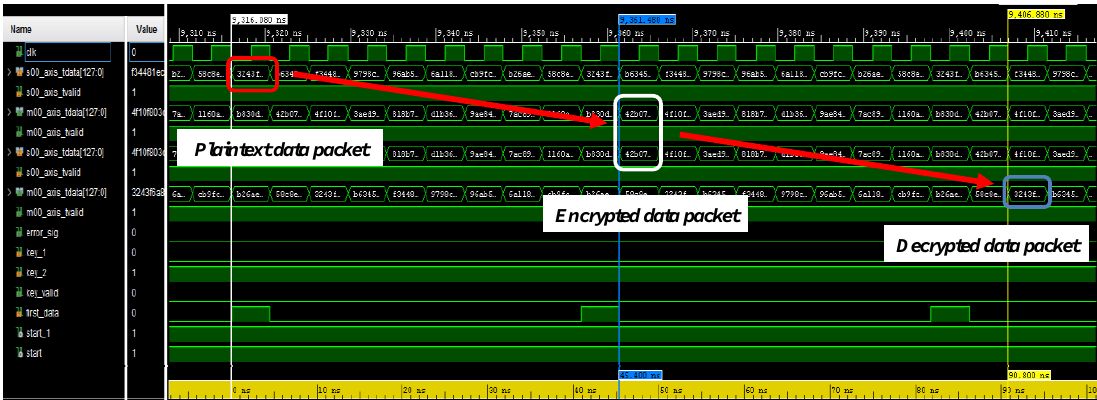
Figure 22. Behavioral simulation with the plaintext data packets (red box) acquired by the system on each rising edge of the clock with frequency 220 MHz and a data rate of 28.16 Gbit/s; the encrypted packets (white box) are obtained after 45.40 ns after receiving them and the decrypted ones (blue box) after 90.80 ns.